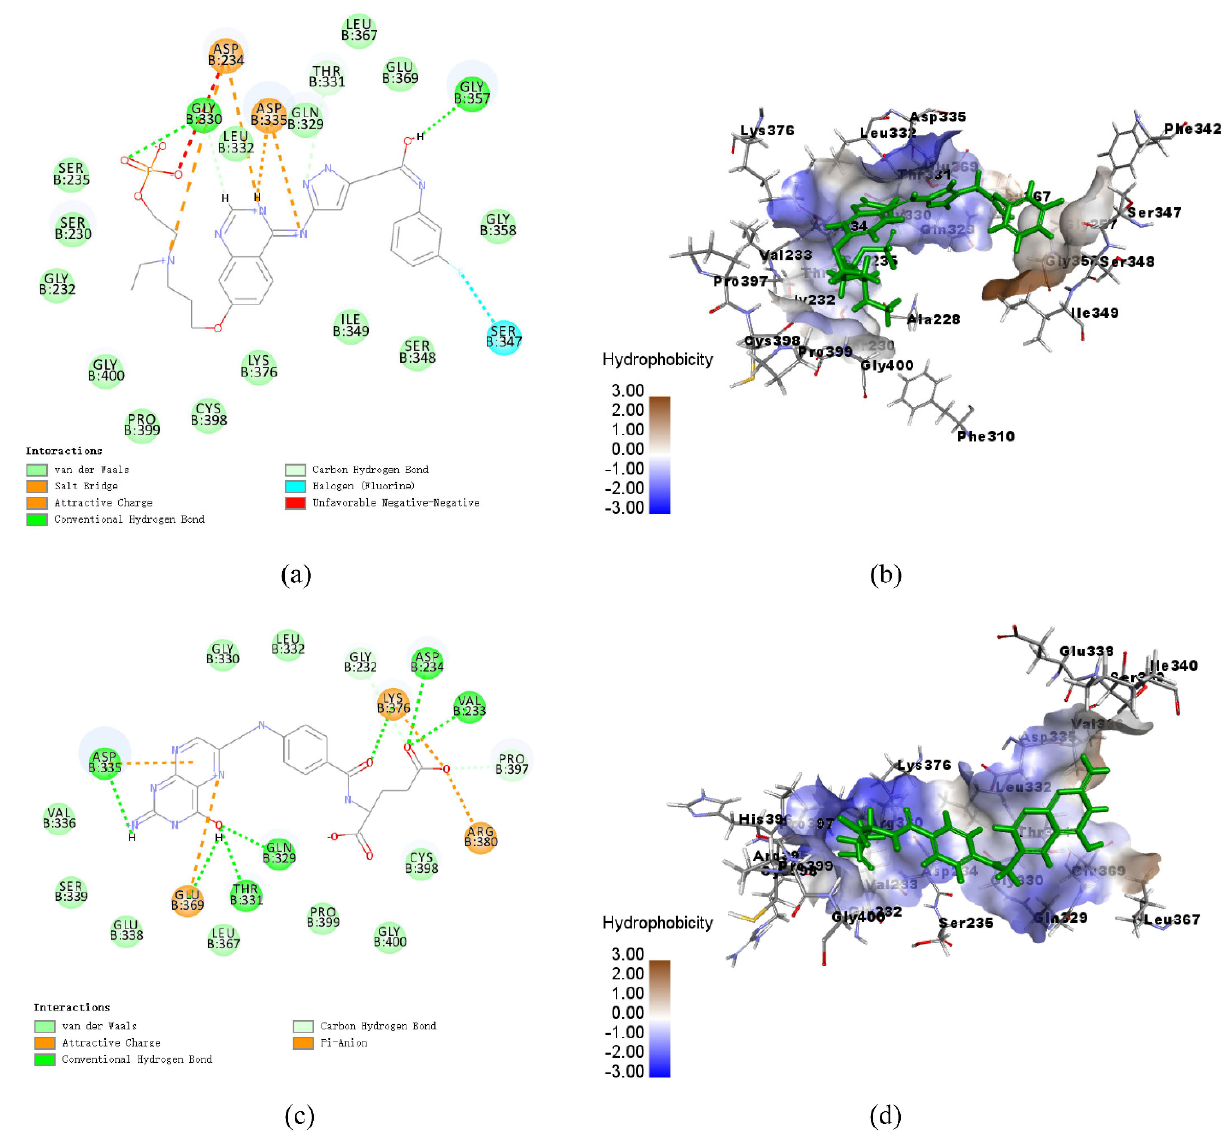
Figure 6. Schematic of intermolecular interaction of the predicted binding modes of C Las GMPS with the molecules. ( a ) 2D details of C Las GMPS and folic acid interaction; ( b ) 3D details of C Las GMPS and folic acid (blue) interaction; ( c ) 2D details of C Las GMPS and AZD1152 (blue) interaction; ( d ) 3D details of C Las GMPS and AZD1152 interaction.